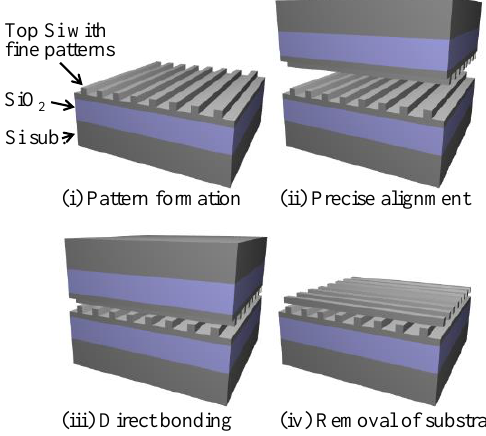
Figure 1. Schematic of the fabrication process of 3D photonic crystal.